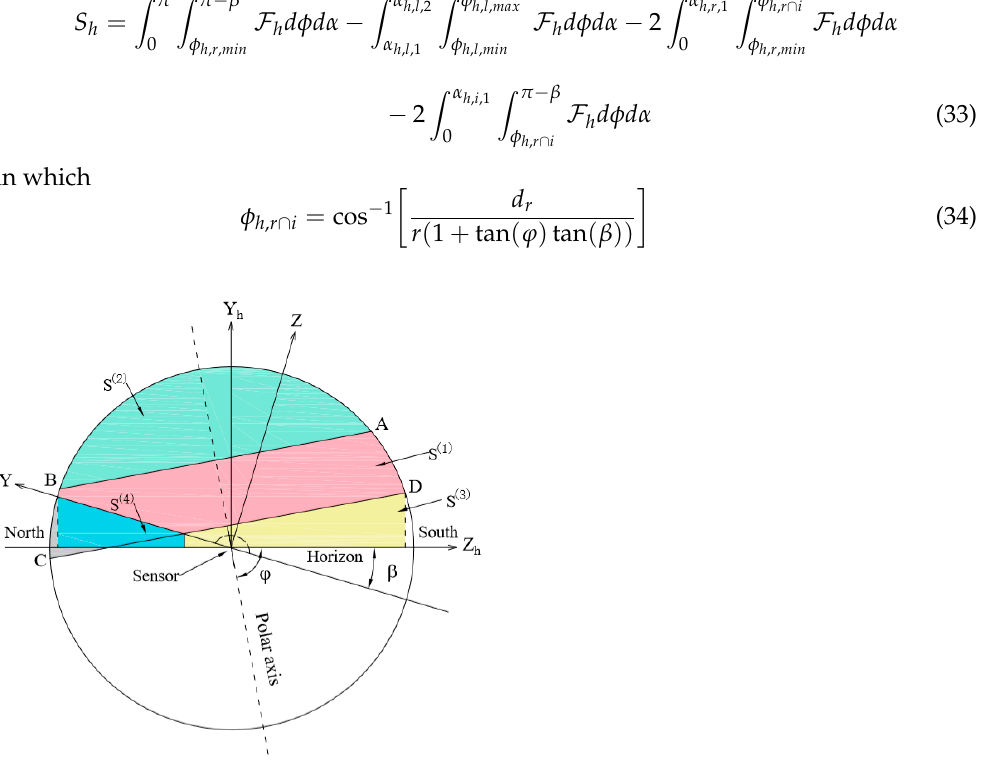
Figure 11. Schematic diagram for the calculation of S h while d r ≤ 0, y h , C > 0 and φ h , r , max < π − β , φ h , r , max ≥ φ h , r ∩ i ≥ φ h , r , min